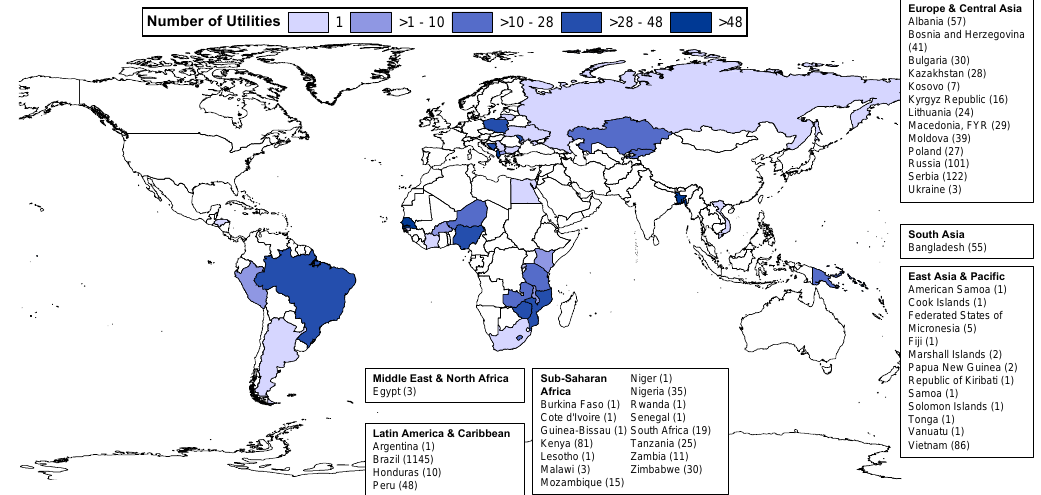
Figure 1. Countries with utilities meeting inclusion criteria and included in the dataset used for analysis. The number of utilities in each country is given in parenthesis next to country name. Water 2018 , 10 , x FOR PEER REVIEW